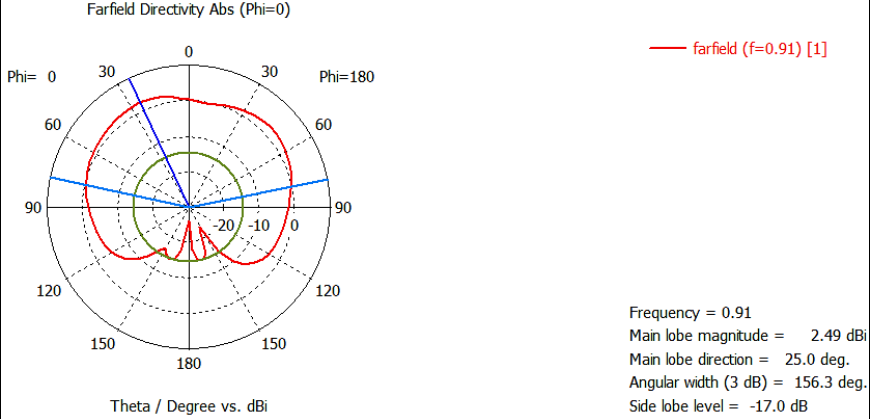
Figure 6. Antenna pattern at first frequency ( 𝑷𝒉𝒊 = 𝟎 )